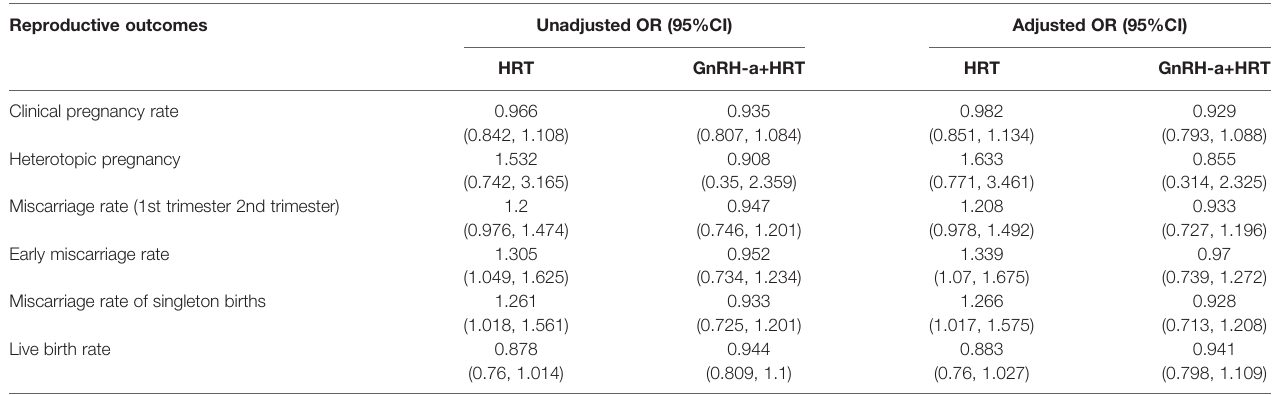
TABLE 4 | Unadjusted and adjusted ORs of the reproductive outcomes following the NC versus HRT and GnRH-a+HRT. Reproductive outcomes